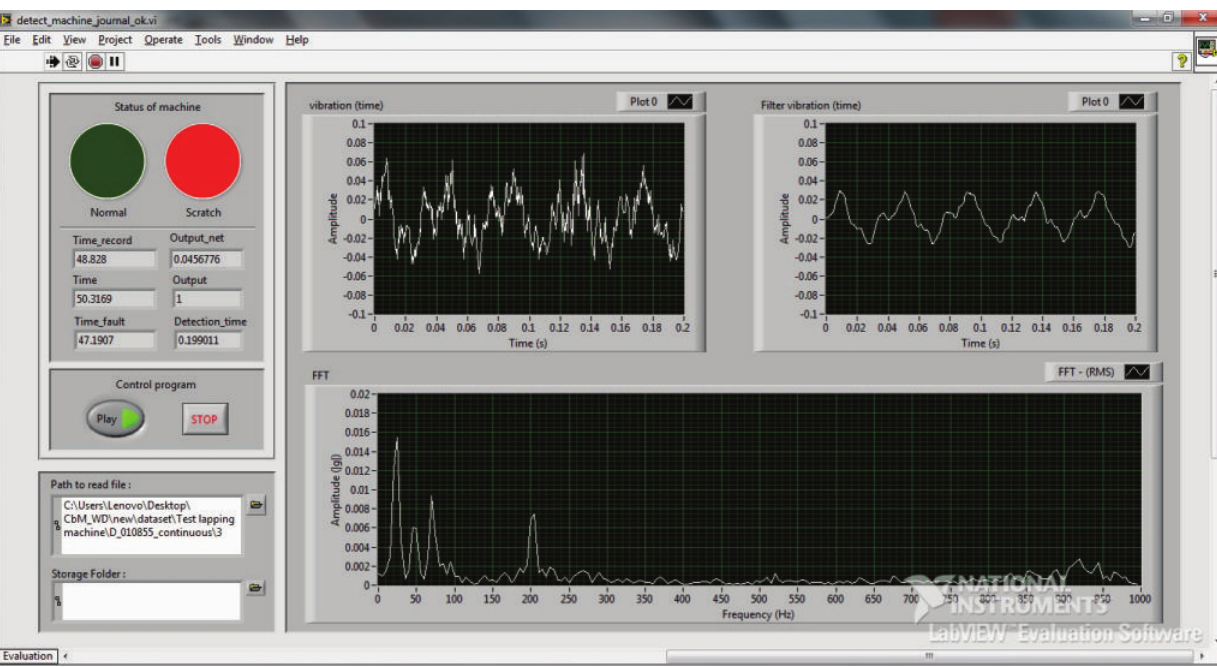
Figure 17: PS detection